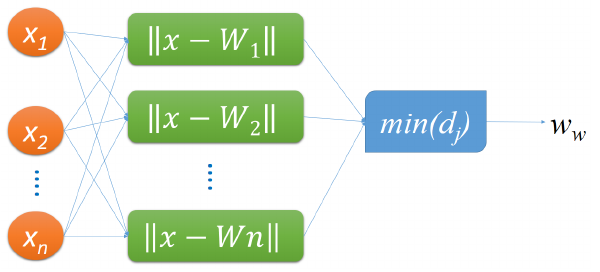
Figure 2. The LVQ